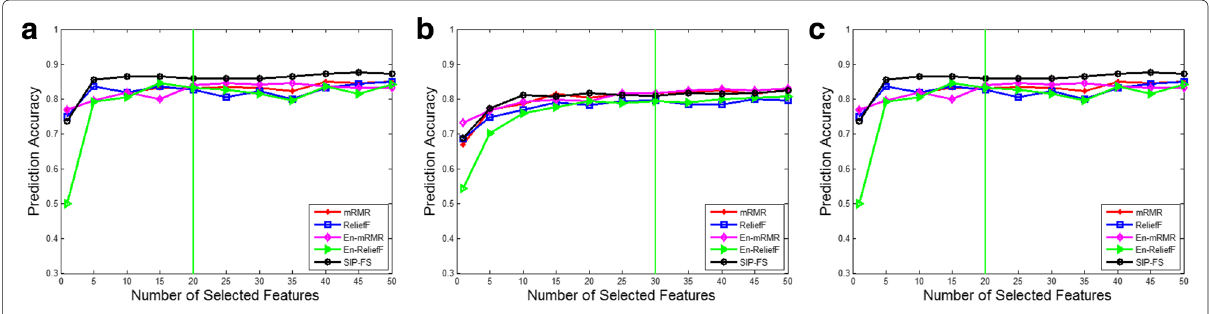
Fig. 9 The number of selected features on predictability performance. a “trees” in MIML. b “flowers” in NUS-WIDE-LITE. c “building” in